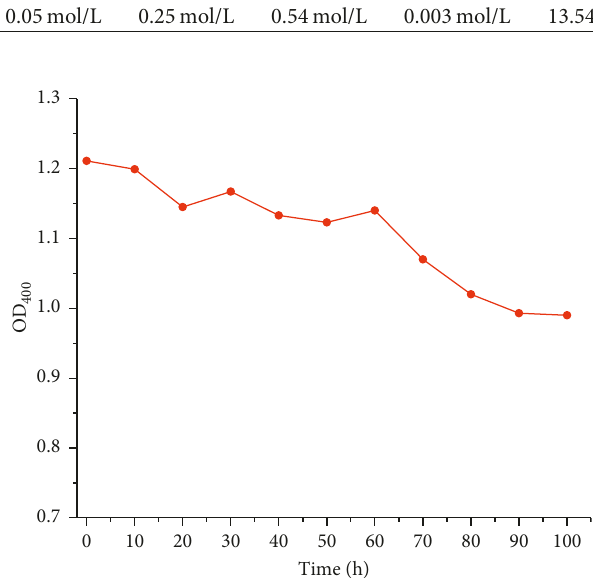
Figure 3: Survival capacity of bacterial in simulation of pore so- lution of steel slag materials.